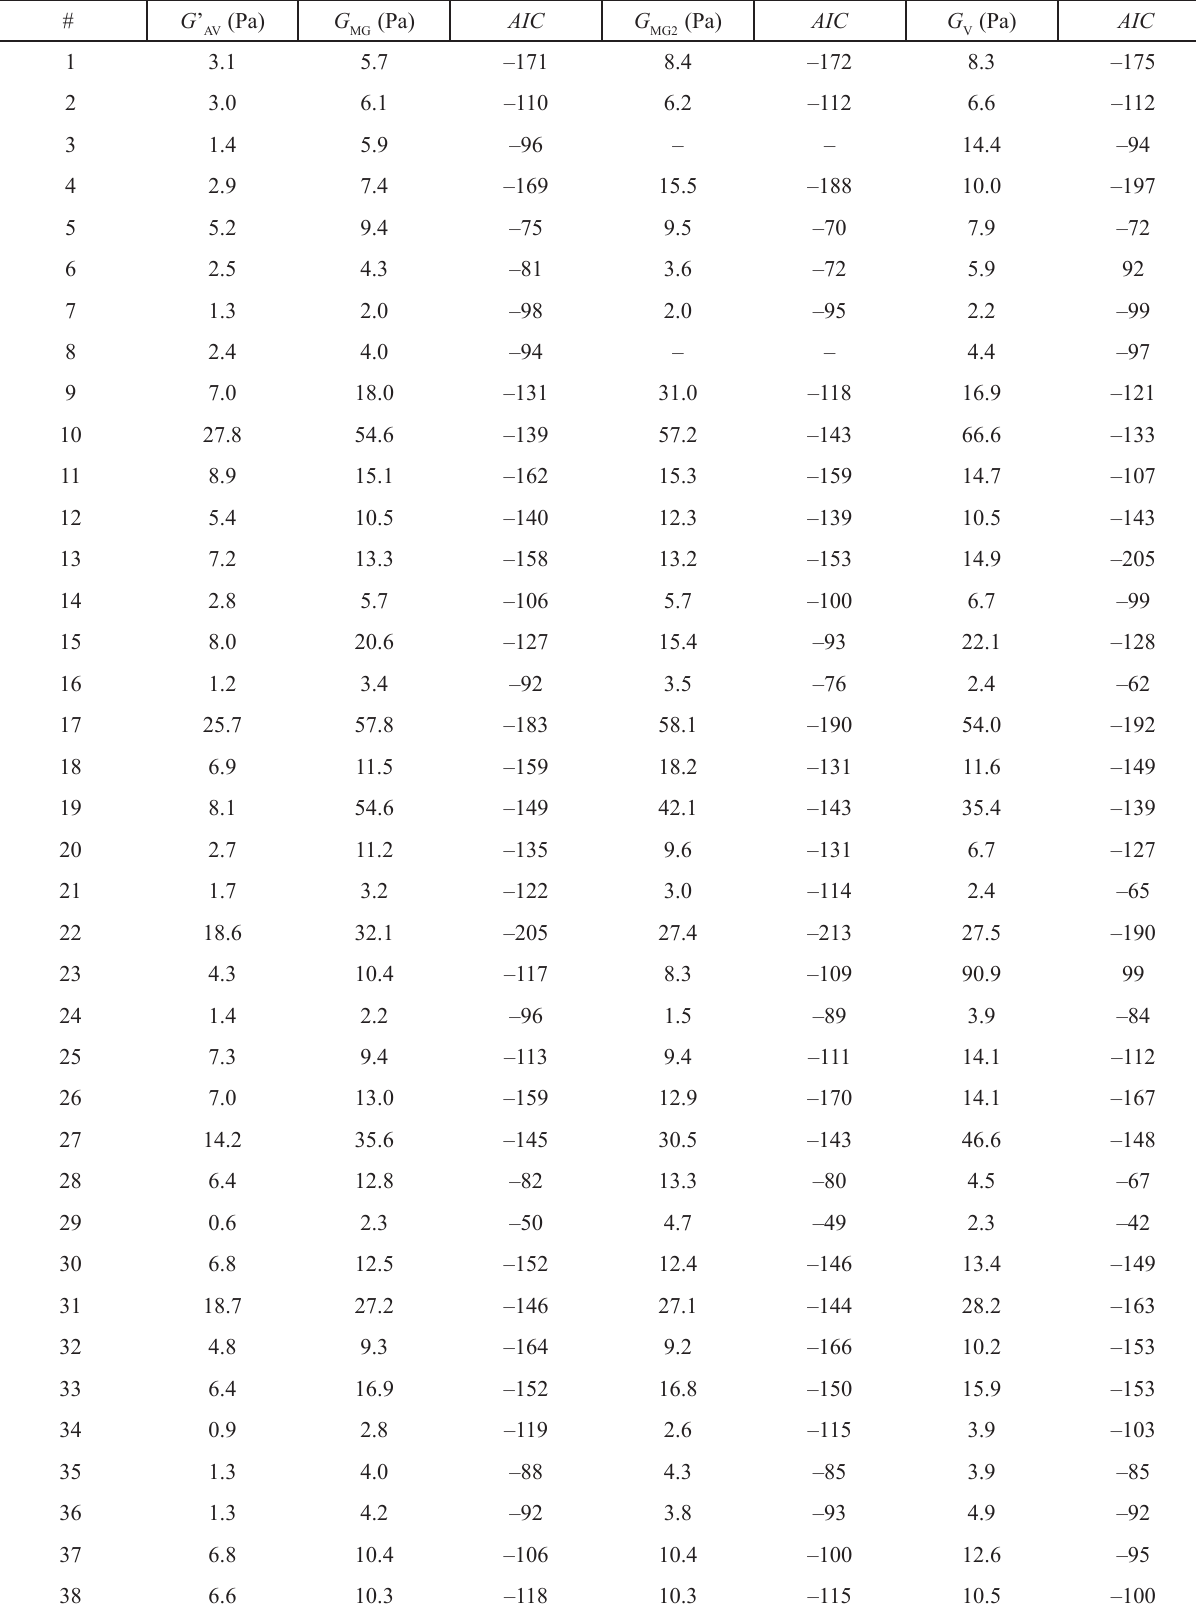
) and shear modulus evaluated according to generalised Maxwell model fitting to mechan- AV scaled by a factor 10 (G ) or let to freely change (G )), and shear modulus i MG MG2 scaled by i